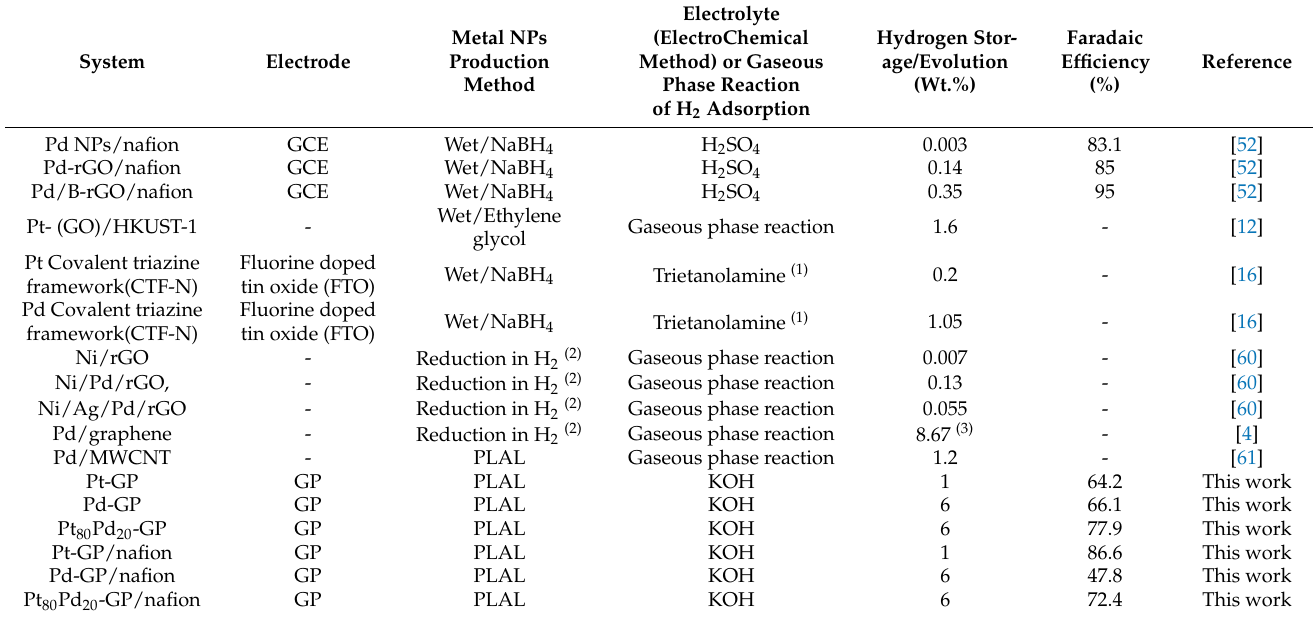
Table 4. Performances of hydrogen evolution and adsorption of the systems described in this work in comparison with some platinum and palladium nanoparticles-decorated carbon nanomaterials reported in